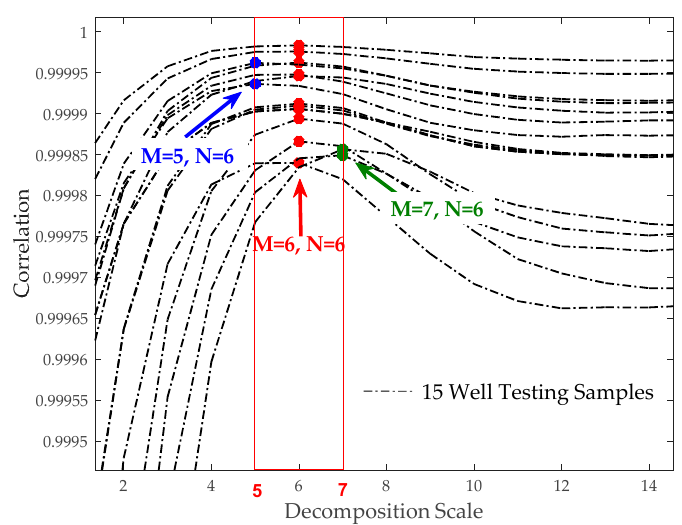
Figure 7. Correlation comparison of different decomposition scales using a sym6 wavelet basis.